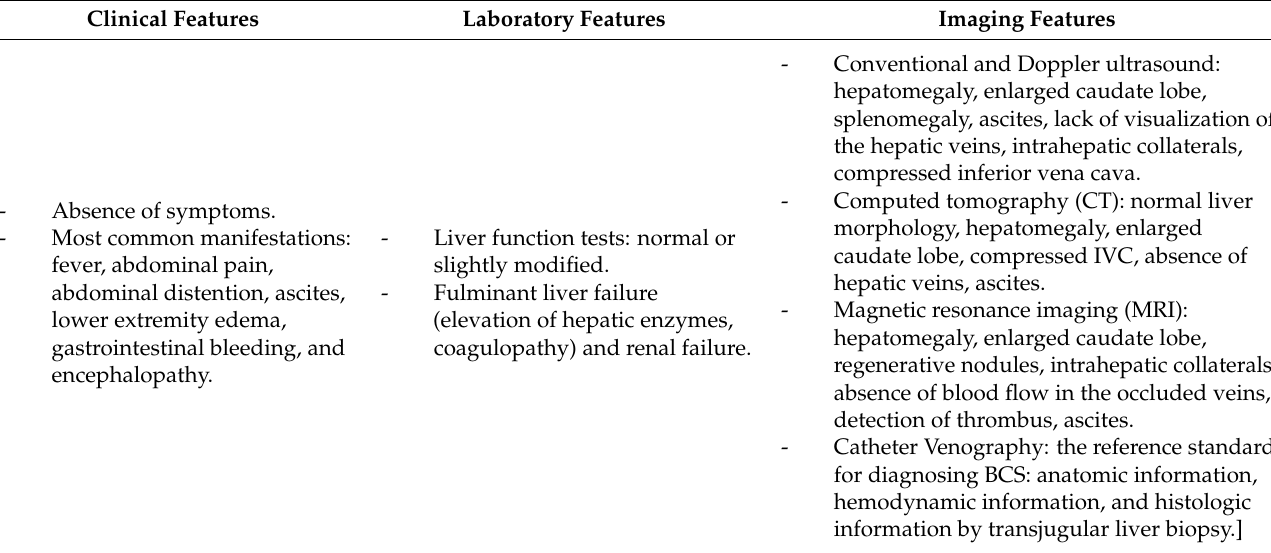
Table 9. Diagnosis of BCS in pregnancy. Data from Ref